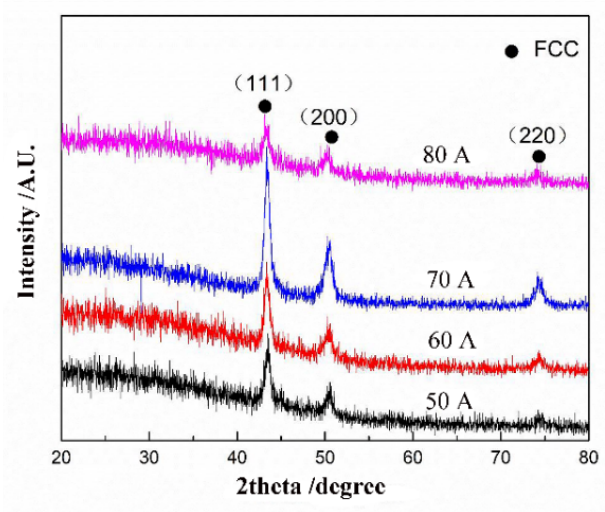
( f ) Figure 6. EDX maps of elements in the middle part of the CoCrFeNiMn coating prepared at 70 A plasma arc current: ( a ) microstructure; ( b ) Cr distribution; ( c ) Mn distribution; ( d ) Fe distribution; ( e ) Ni distribution; ( f ) Co distribution . 3.2. Phases Figure 7 shows the X-ray diffraction patterns of CoCrFeNiMn HEA coatings pre- pared by plasma transfer arc cladding at different plasma currents. It was found that CoCrFeNiMn HEA coatings mainly had three characteristic peaks at 43.23°, 52.69° and 73.60°. According to the research results of references [27] and PDF cards (PDF card No. 33-0397), the characteristic peaks corresponded to the (111), (200) and (220) lattice planes of face centered cubic (FCC) solid solutions, respectively. Therefore, the HEA coatings consisted of a single FCC phase, which was similar to the single FCC phase of FeCrNiCo high entropy alloy coating reported in Zhang’s work [28]. The formation of a single FCC structure could be related to the fact that the elements selected for the preparation of the alloys were all adjacent elements of the fourth period and their atomic radii were similar [29]. According to the Gibbs phase ratio [30], the number of equilibrium solidification phases of n elements is p = n + 1, and the number of non-equilibrium solidification phases is p > n + 1. It could be found from Figure 7 that the phase number of CoCrFeNiMn HEA coating was one, which was less than six. Since the CoCrFeNiMn HEA had a high mixing